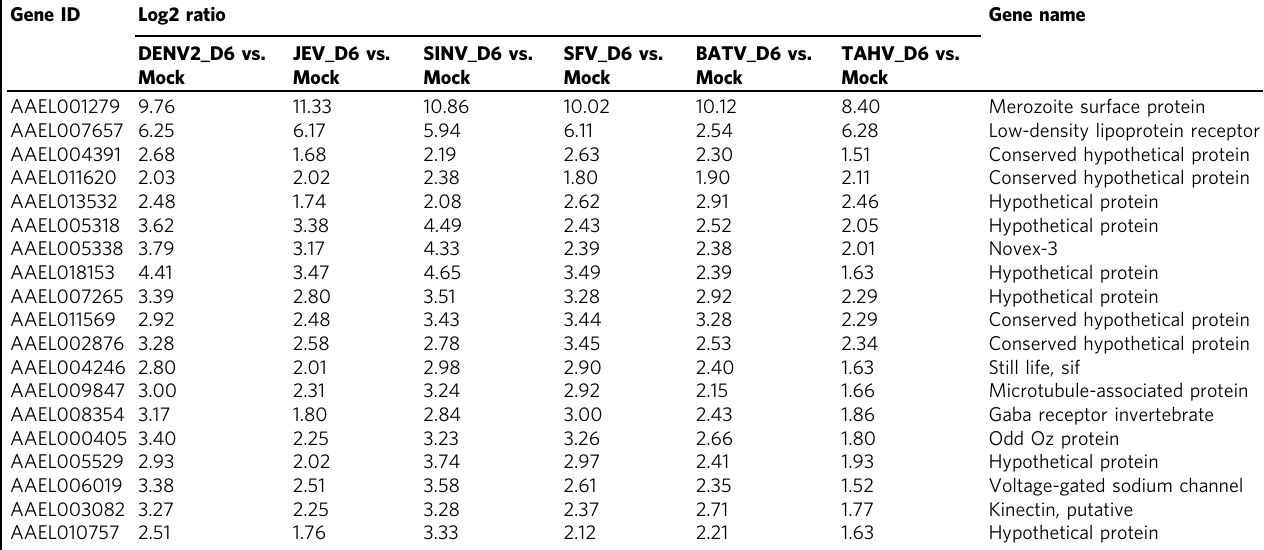
Table 1 Information for the 19 induced genes consistently identi fi ed at 6 days post-infection with arboviruses Gene ID Log2 ratio Gene name DENV2_D6 vs. Mock